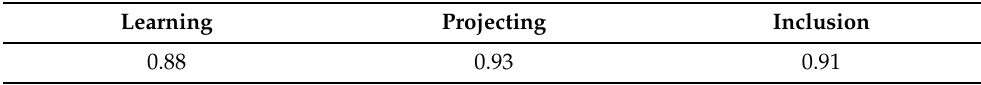
Table 5. WBLT rating scale results.